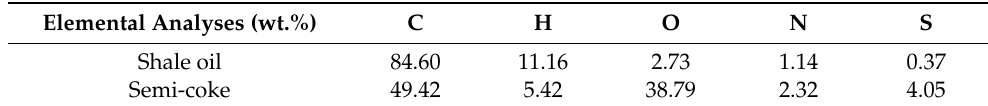
Table 3. Elemental analyses of shale oil and semi-coke.